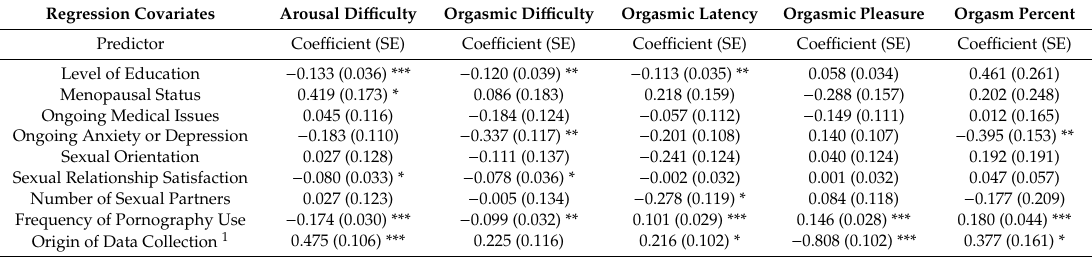
Table 3. Ordered logistic regression results for predicting arousal di ffi culty and orgasmic di ffi culty, latency, and pleasure during masturbation. Fractional response regression results for predicting the percent of time reaching orgasm during